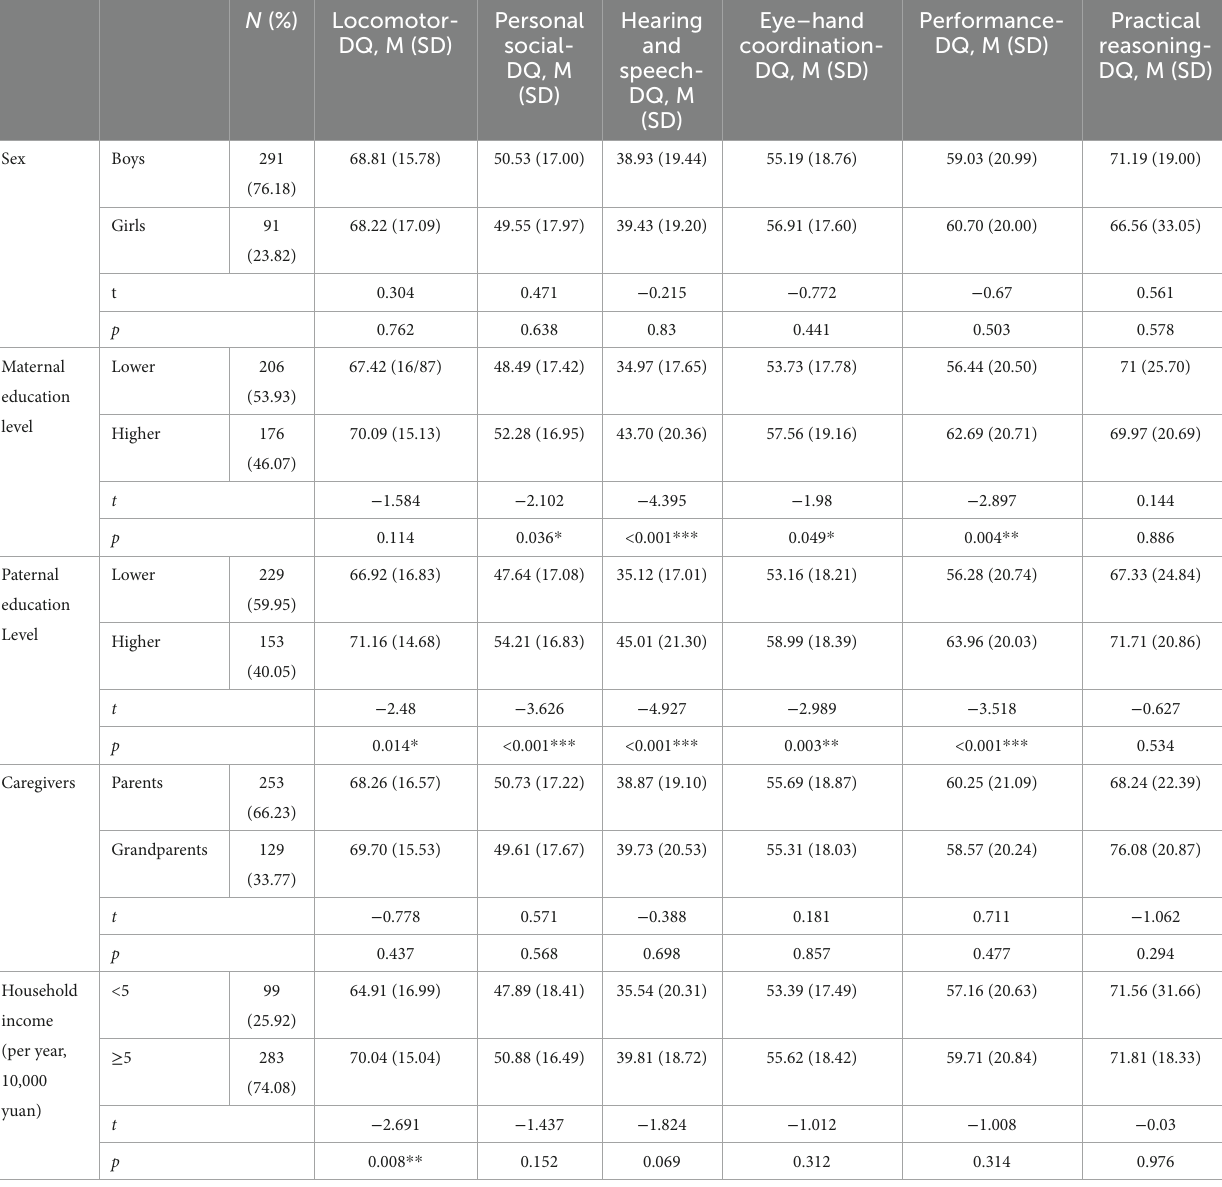
TABLE 3 Comparison of DQ scores in each group (grouped by sex, maternal education level, paternal education level, caregivers and household income). Maternal and paternal education levels were defined as higher (junior college or above) or lower (senior high school or